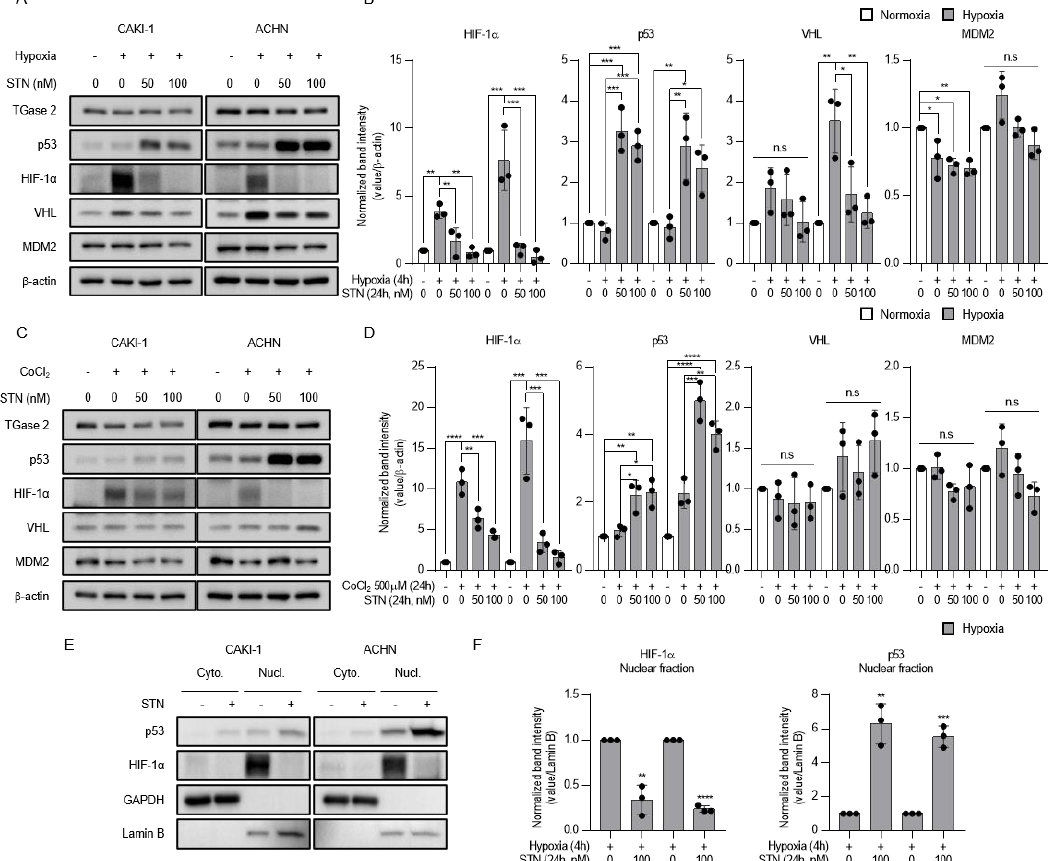
Figure 2. TGase 2 inhibition induces p53-dependent inhibition of hypoxia-inducible factor (HIF)-1 α in hypoxia. ( A ) Cells were treated with STN (streptonigrin, TGase 2 inhibitor) for 24 h and incubated for 4h in hypoxia (1% O 2 ). ( B ) The image J analysis of Western blotting of Figure 2A. ( C ) Cells were treated with STN and CoCl 2 (cobalt chloride, 500 µ M) and incubated for 24 h in normoxia. Whole cell lysates were subjected to the immunoblotting with indicated antibodies. β -actin was used as a loading control. ( D ) The image J analysis of Western blotting of Figure 2C. ( E ) Cells were treated with or without STN (100 nM) for 24 h and incubated for 4 h in hypoxia (1% O 2 ). GAPDH was used as a cytosolic fraction loading control and Lamin B was used as a nuclear fraction loading control. ( F ) The image J analysis of Western blotting of Figure 2E. Densitometry of proteins in nuclear fraction is used to normalize the Lamin B. Error bar represents SD. GraphPad Prism software used to perform one-way ANOVA or t-test, * p < 0.05, ** p < 0.01, *** p < 0.001, **** p < 0.0001. ns = not significant. Data are representative of three independent experiments.